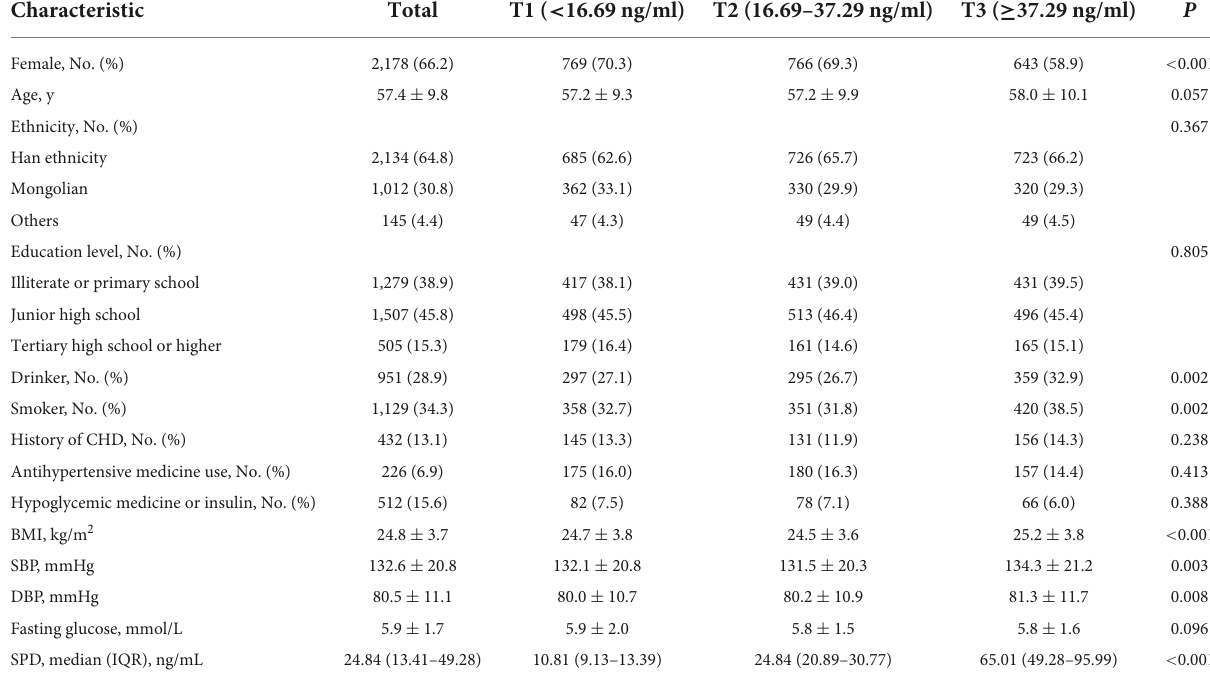
TABLE 1 Baseline characteristics stratified by spermidine (SPD) tertile. a